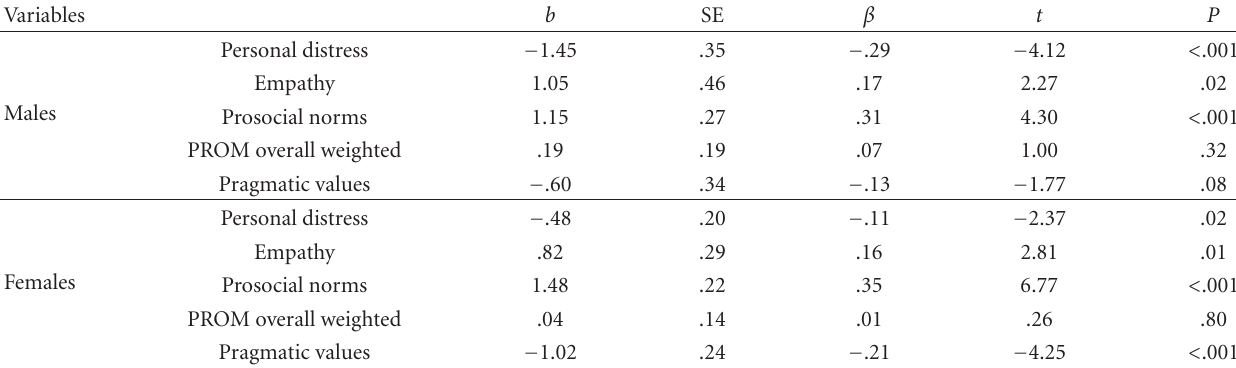
Table 4: Prediction of prosocial behavior (ABQ score) among males and